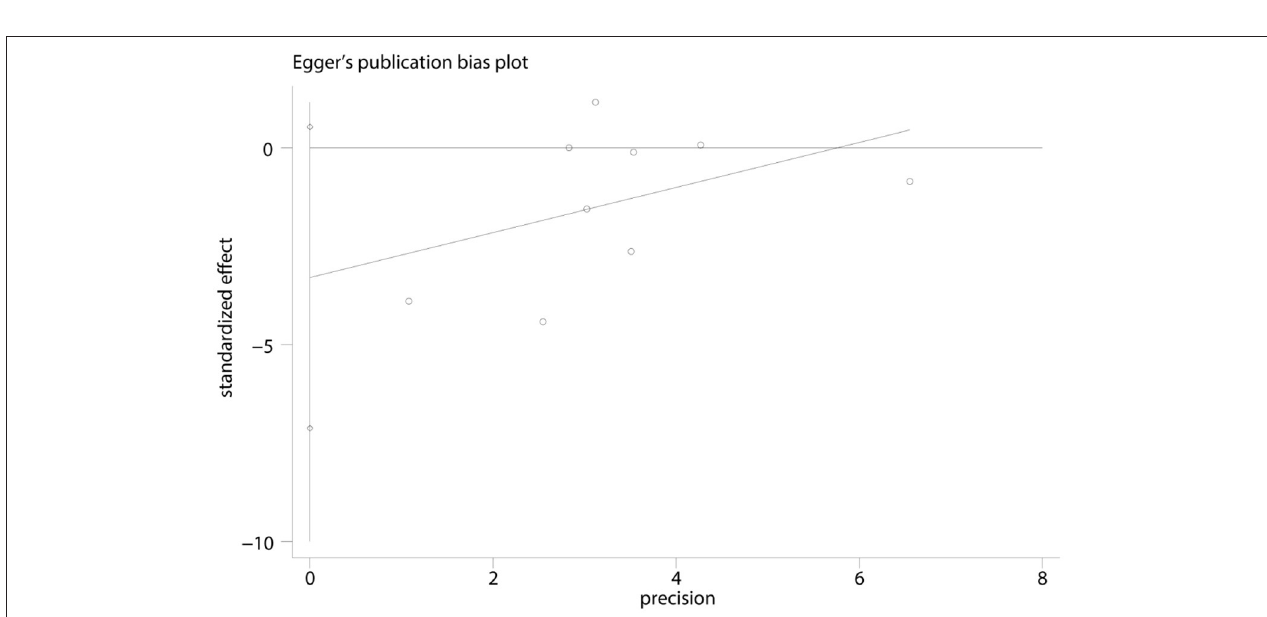
FIGURE 5 | Egger’s plot on sleep quality for the evaluation of the publication bias of the literature.